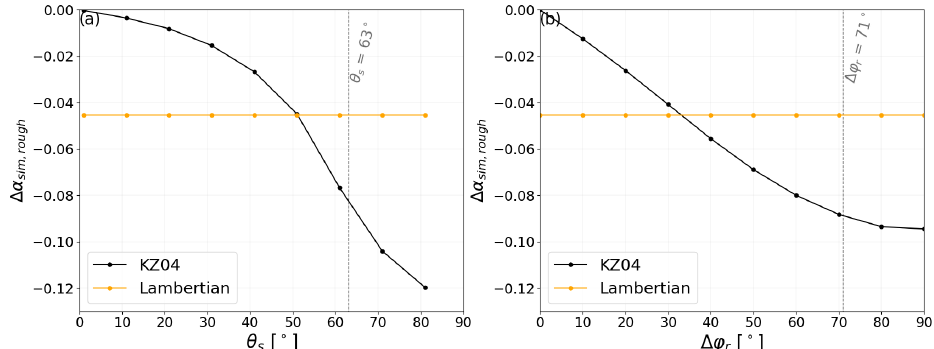
Figure 11. Variations in (cid:49)α sim , rough ([rough–smooth] at same illumination) simulated with RSRT at 1000nm with the initial condition of the experiment A η 27%, without slope as a function of (a) θ s (in degrees) and a constant (cid:49)ϕ r = 71 ◦ and (b) (cid:49)ϕ r and a constant θ s = 63 ◦ . Simulations are performed with the Lambertian configuration (in orange) and the KZ04 configuration (in black). Vertical dashed lines indicate the initial condition of the experiment A η 27% (Table 1).